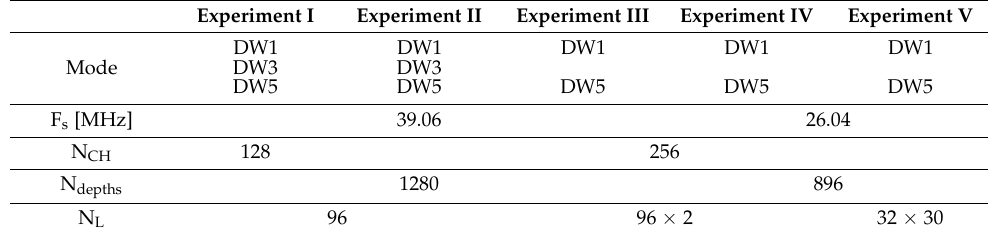
Table 2. Table of the experiments performed on star and ring topologies. Experiment